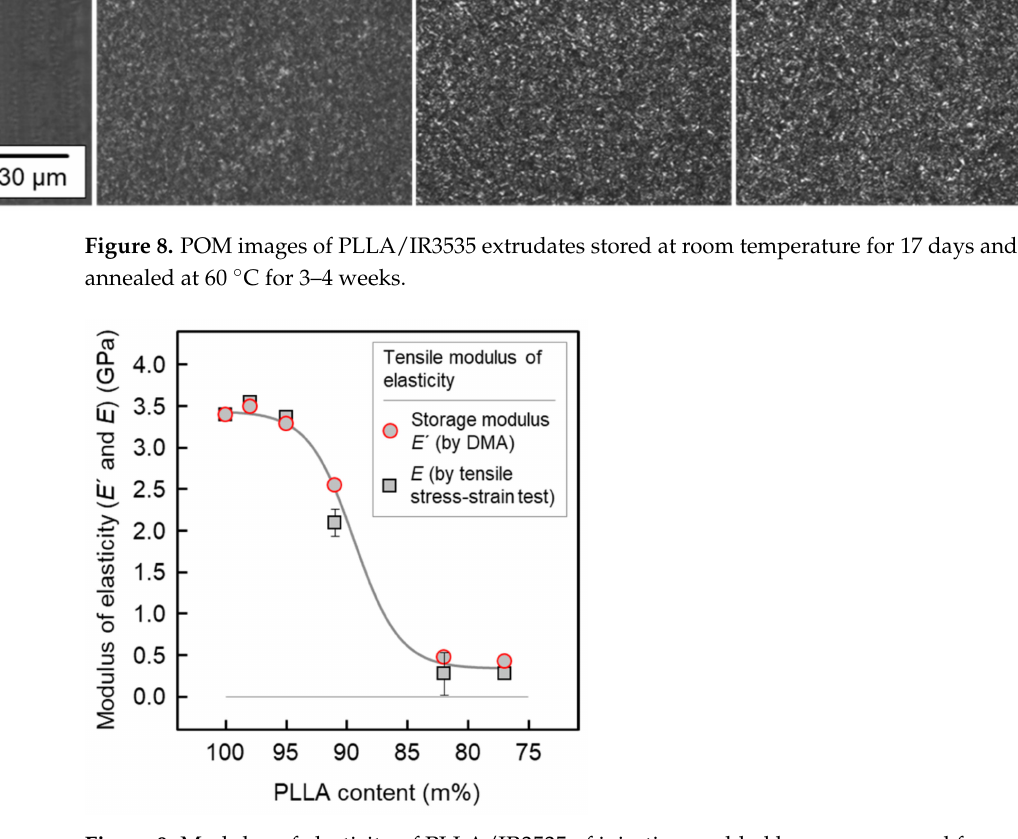
Figure 9. Modulus of elasticity of PLLA/IR3535 of injection-molded bars, reprocessed from extru- dates, and measured by tensile stress–strain testing (black squares) and DMA (red circles) at room temperature. The line is drawn to guide the